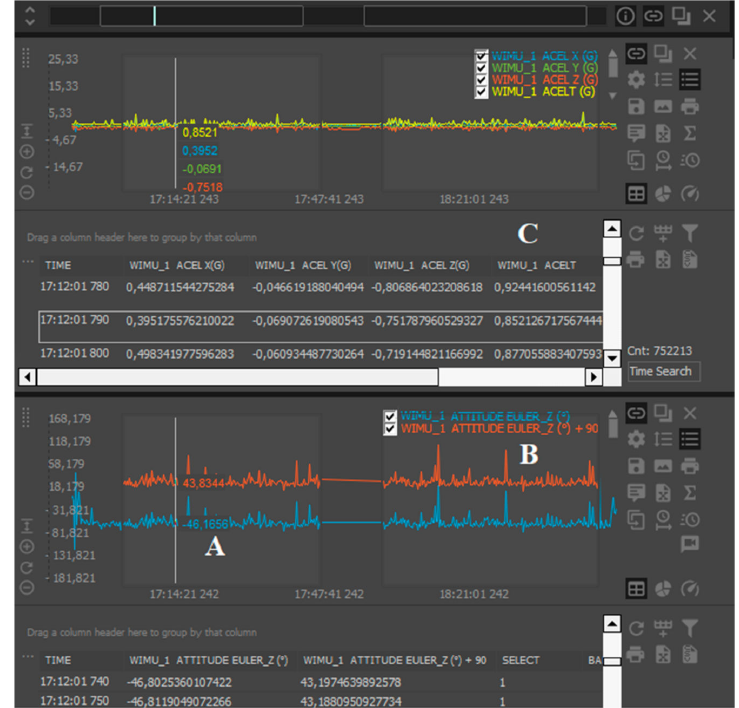
Figure 3. Raw data from “ATTITUDE EULER Z” ( A ), “ATTITUDE EULER Z plus 90” to obtain the right position ( B ), and “ACELT” ( C